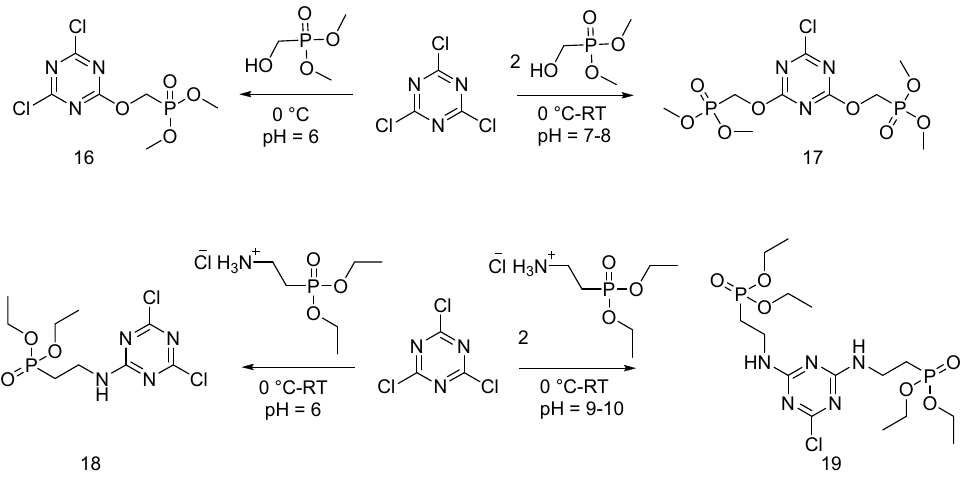
Figure 11. Synthesis of flame retardants ( 16 )–( 19 ) via nucleophilic reaction.